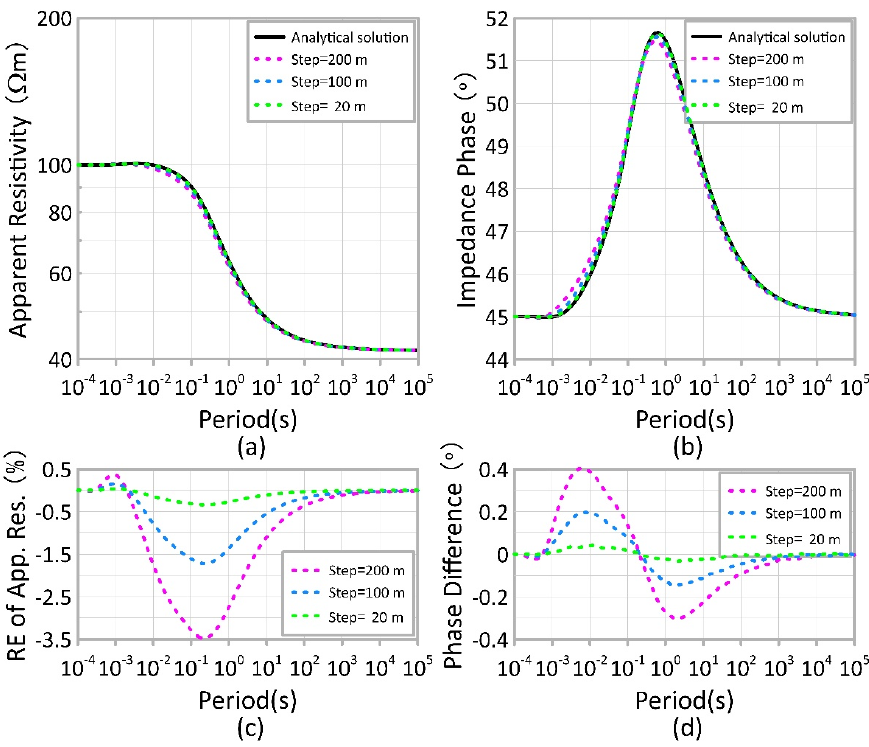
Figure 3. Comparison of the MT soundings given by the algorithm presented in this work for the exponential model denoted by the black solid line shown in Figure 2 and those obtained using the Pek1DAniCode for the stair-step models shown by magenta, blue and green dashed lines in Figure 2. ( a ) Apparent resistivity. ( b ) Impedance phase. ( c ) Relative error (RE) of the apparent resistivity. ( d ) Phase difference (PD). The results calculated using the method in this study are as by “Analytic solution” in the legend, and the results for the stair-step model with a step of 200 m are marked as “Step = 200 m” (and similarly for the other stair-step models). See the text for details. To evaluate the accuracy of the algorithm in this work, the relative error (RE) of the apparent resistivity of the different models was introduced, and the phase difference (PD)